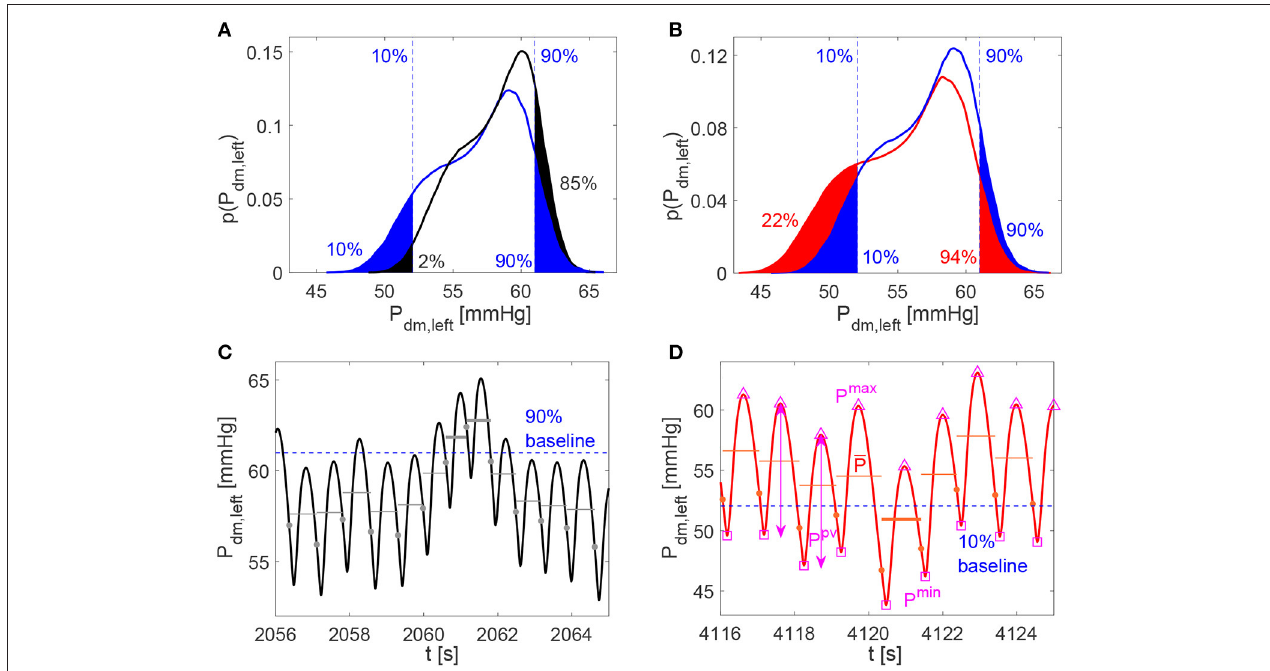
FIGURE 3 | (A,B) Examples of percentile evaluation for P dm , left ( p ( P dm , left ) is the probability density function). Ten and 90% blue dashed lines individuate the 10th and 90th percentiles in the baseline configuration ( A,B , blue areas), while they correspond to the 2nd and 85th percentiles in the decreased HRV configuration ( A , black areas), and to the 22nd and 94th percentiles in the increased HRV configuration ( B , red areas). (C,D) P dm , left examples of hypertensive event lasting two beats in the decreased HRV configuration (average pressure per beat, P , is represented by gray horizontal lines and hypertensive events are marked with bold gray lines) and hypotensive event in the increased HRV configuration ( P is represented by red horizontal lines and hypothensive events are marked with bold red lines). The 10th and 90th percentile baseline thresholds are displayed through the dashed blue horizontal lines, while full circles indicate the heartbeat extremes. In (D) examples of P max ( △ ), P min ( 2 ), and P pv ( ↔ ) values per beat are evidenced for P dm , left .